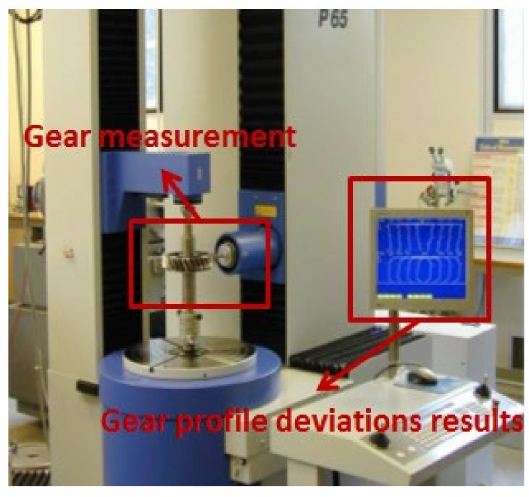
Figure 5. Gear measurement before testing on a gear measurement machine.